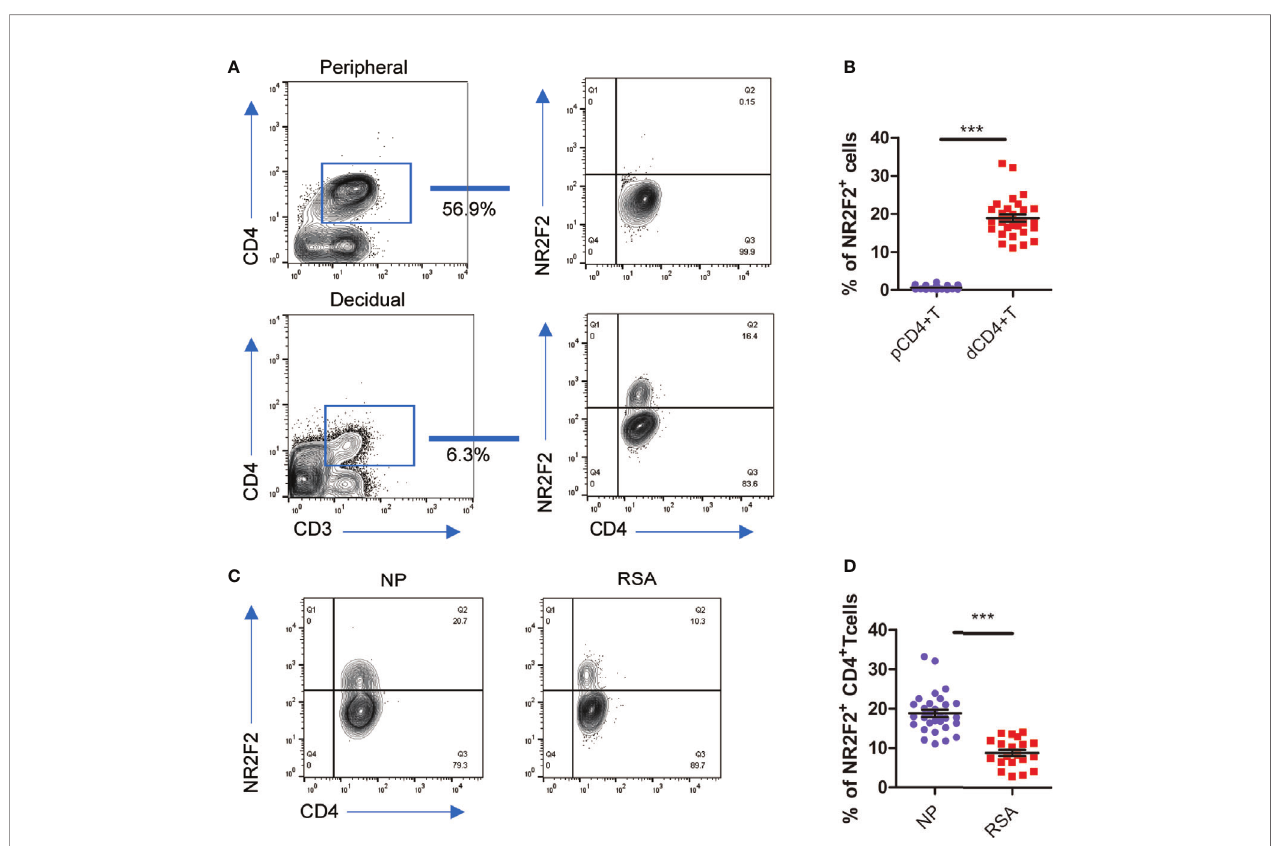
FIGURE 2 | NR2F2 expression in decidual CD4 + T cells during early pregnancy. (A) Representative image showing the analysis of NR2F2 expression in dCD4 + T and pCD4 + T cells during the fi rst trimester. (B) Relative number of NR2F2 + CD4 + T cells in gated CD3 + CD4 + decidual and peripheral immune T cells (n=30). Data are presented as the mean ± SEM. *** P < 0.001. (C) Representative image showing the analysis of NR2F2 expression in dCD4 + T cells from NP and RSA during the fi rst trimester. (D) Relative number of NR2F2 + CD4 + T cells from NP(n=30) and RSA (n=20). Data are presented as the mean ± SEM. *** P <